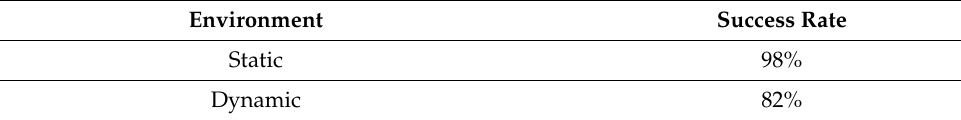
Table 1. Success and Collision